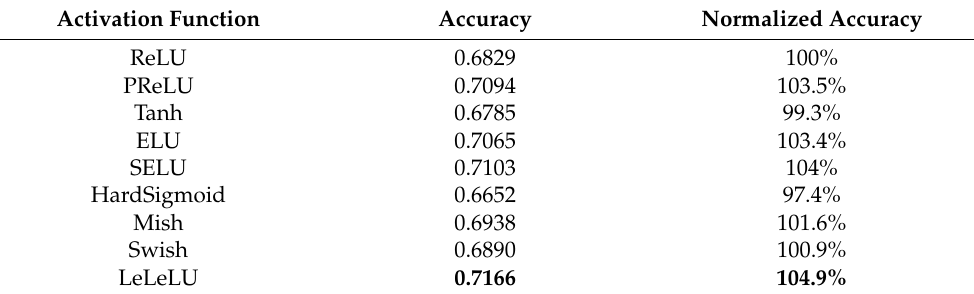
Table 4. Test accuracy in the CIFAR-10 dataset of the activation functions in question, using the corresponding neural network, and accuracy normalized to that attained by ReLU activation